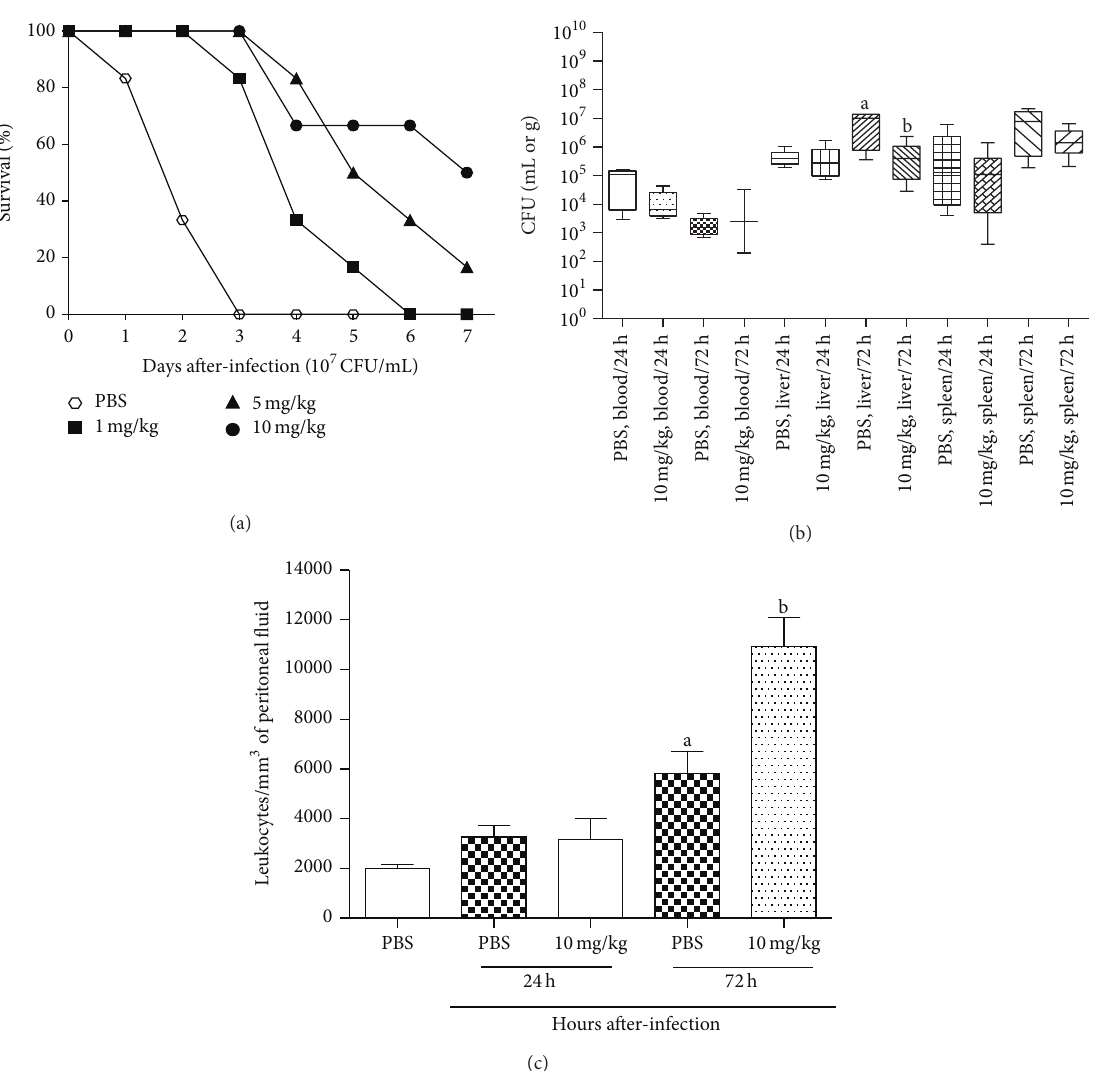
Figure 1: Survival, bacterial clearance and inflammation in Swiss mice pretreated with P1G10 and infected with Salmonella Typhimurium. Survival was evaluated in mice pretreated with 1, 5, or 10mg/kg of PIG10 intraperitoneally (a). The control groups received PBS (b). The bacterial cell counts in blood, spleen, and the liver were evaluated 24 h and 72 h after infection as well as the total leukocyte cell counts in the peritoneal fluid (c). Results are expressed as mean ± SD and data comparison was by Student’s 𝑡 -test or analysis of variance (ANOVA) followed by the Turkey test. The confidence interval was determined with 𝑃 < 0.05 . Different superscript letters mean significant difference between P1G10 and PBS